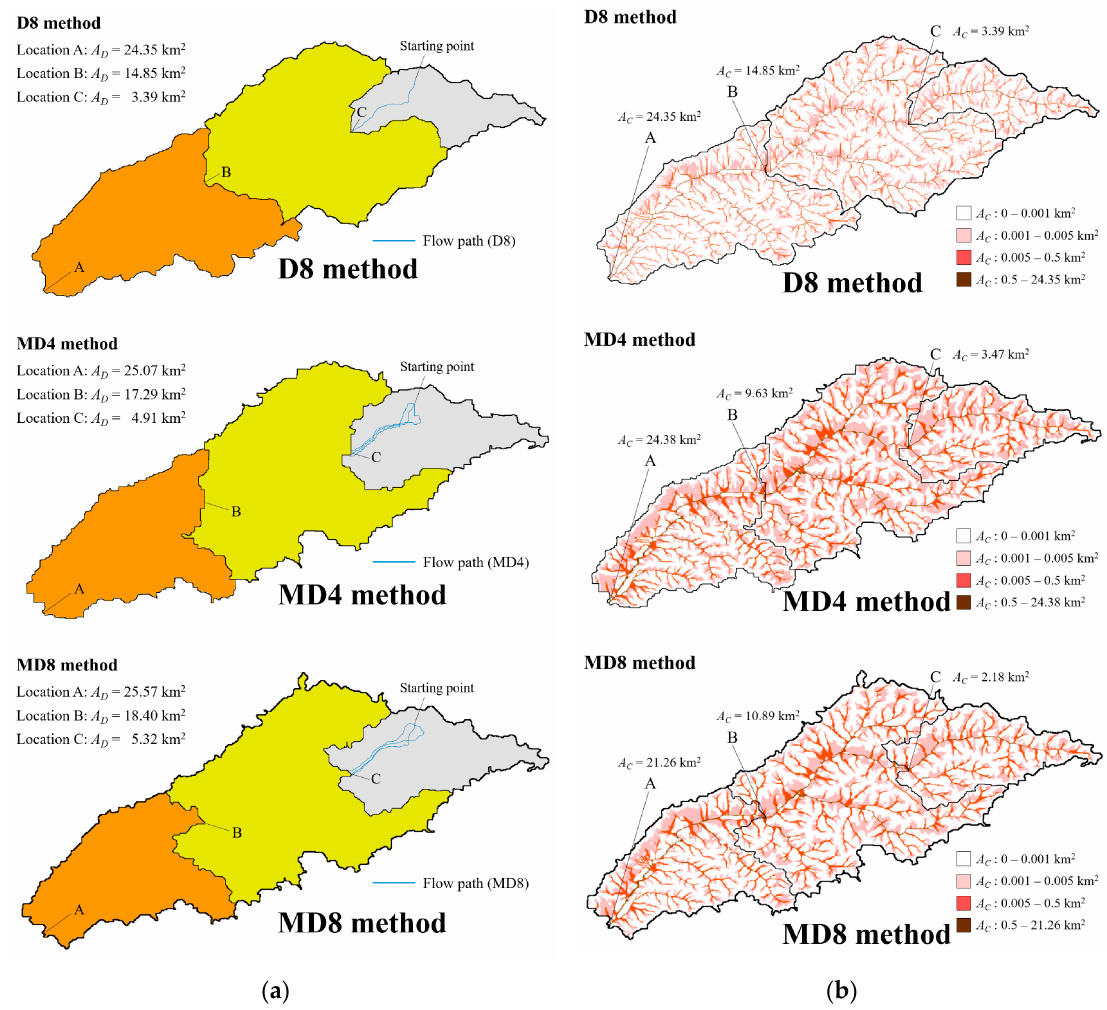
Figure 6. Comparison of area indexes using different flow-direction methods: ( a ) Flow dispersion areas of three designated outlets; ( b ) Distributions of flow concentration areas.